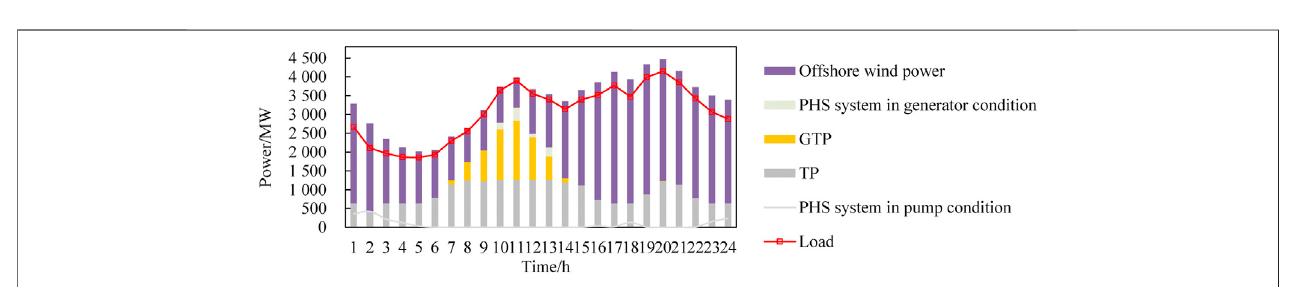
FIGURE 6 | Operation planning result for scenario